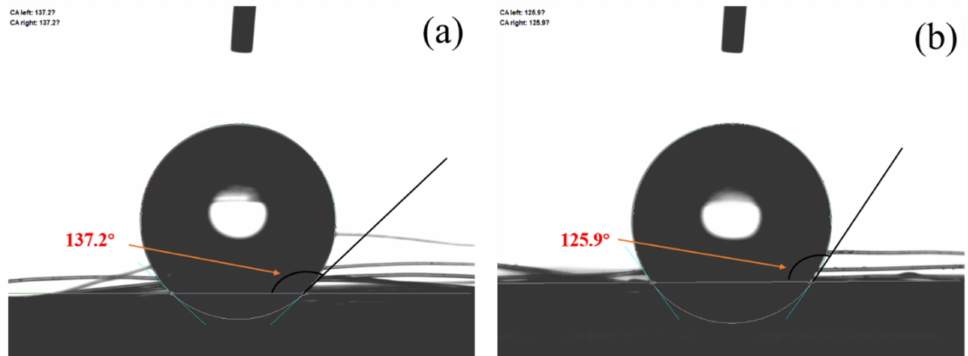
Figure 2. Wetting angle of PP fiber: ( a ) untreated PP fiber; ( b ) treated PP fiber.